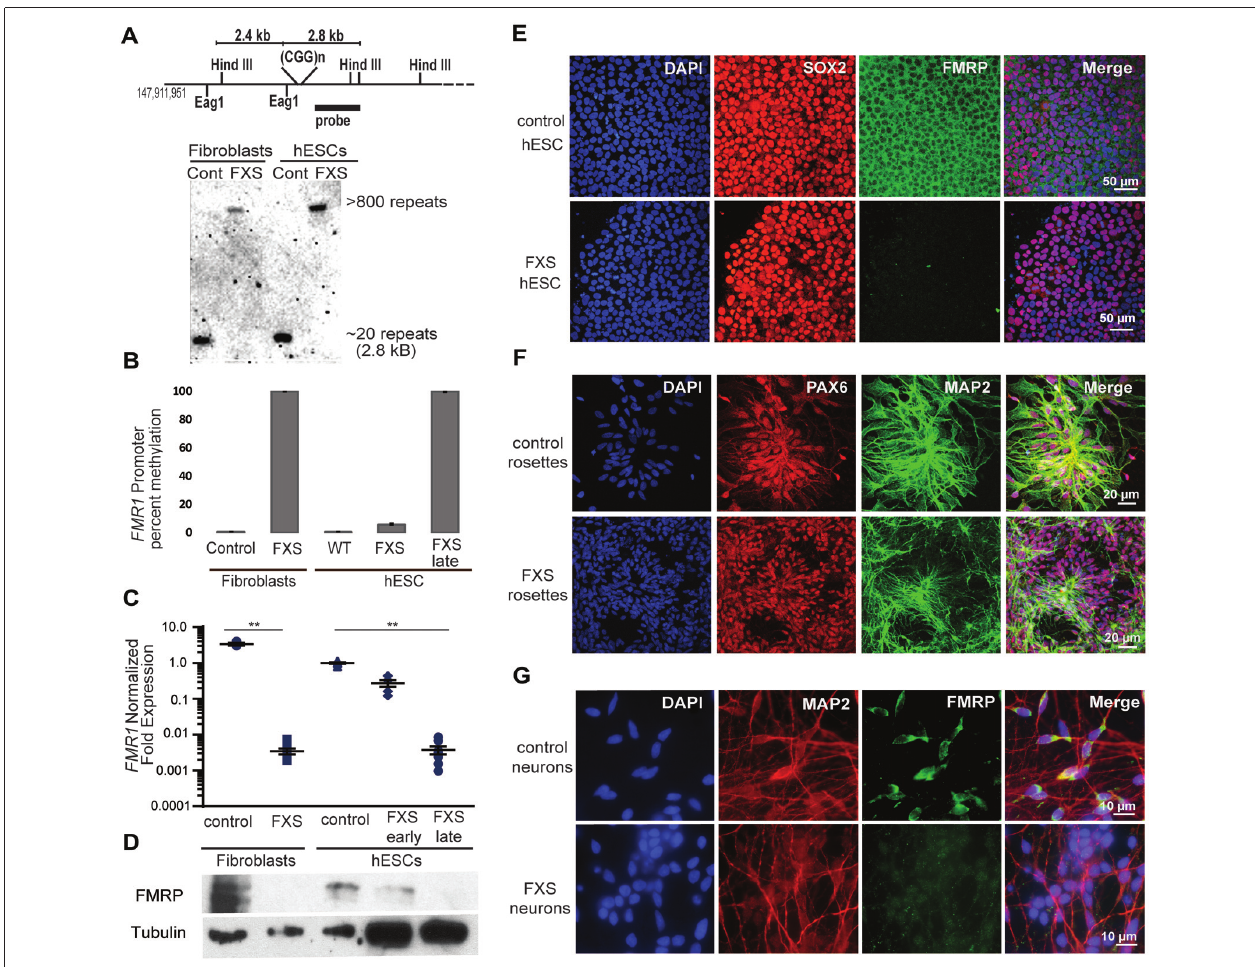
FIGURE 4 | Fragile X hESC line (UM139-2 PGD) carries a large CGG repeat and undergoes passage dependent transcriptional silencing. (A) Top panel: schematic representing the Eag1 and Hind III restriction sites on the FMR1 genomic locus, the digoxigenine (DIG)-labeled probe used for Southern blotting in this study and the expected fragment sizes. The figure is not to scale. Bottom panel- Southern blot shows CGG repeat length and methylation status for genomic DNA from control and Fragile X Syndrome (FXS) patient-derived fibroblasts and hESCs. Repeat size is estimated at < 800. (B) Bisulfite-qPCR using methylation-specific primers reveals a passage dependent methylation at the FMR1 promoter for genomic DNA from indicated cells. Data shown for two independent experiments. (C) Relative FMR1 transcript levels in control and FXS patient-derived fibroblasts and hESCs. FXS hESCs were assessed at early passages (P13–20) and late passages (P30+). ∗∗ p < 0.01, Kruskal-Wallis one-way ANOVA with Dunn’s multiple comparison test, data from five independent experiments, error bar represents SEM. (D) Western blots showing FMRP and tubulin in control and FXS patient-derived fibroblasts as well as control hESC and early and late passage FXS hESCs. One-tenth of the lysate was loaded for control fibroblasts and control hESCs. (E) Undifferentiated control and FXS hESC colonies immunostained for FMRP (green), pluripotency marker SOX2 (red) and DAPI (blue). Scale bars represent 50 µ m. (F) Neural rosettes derived from control and FXS hESCs with neuronal lineage marker MAP2 (green), neuroectoderm maker PAX6 (red), and DAPI (blue) immunostaining. Scale bars represent 20 µ m. (G) Neurons derived from control and FXS hESCs shown with FMRP (green), MAP2 (red) and DAPI (blue) immunostaining. Scale bars represent 10 µ